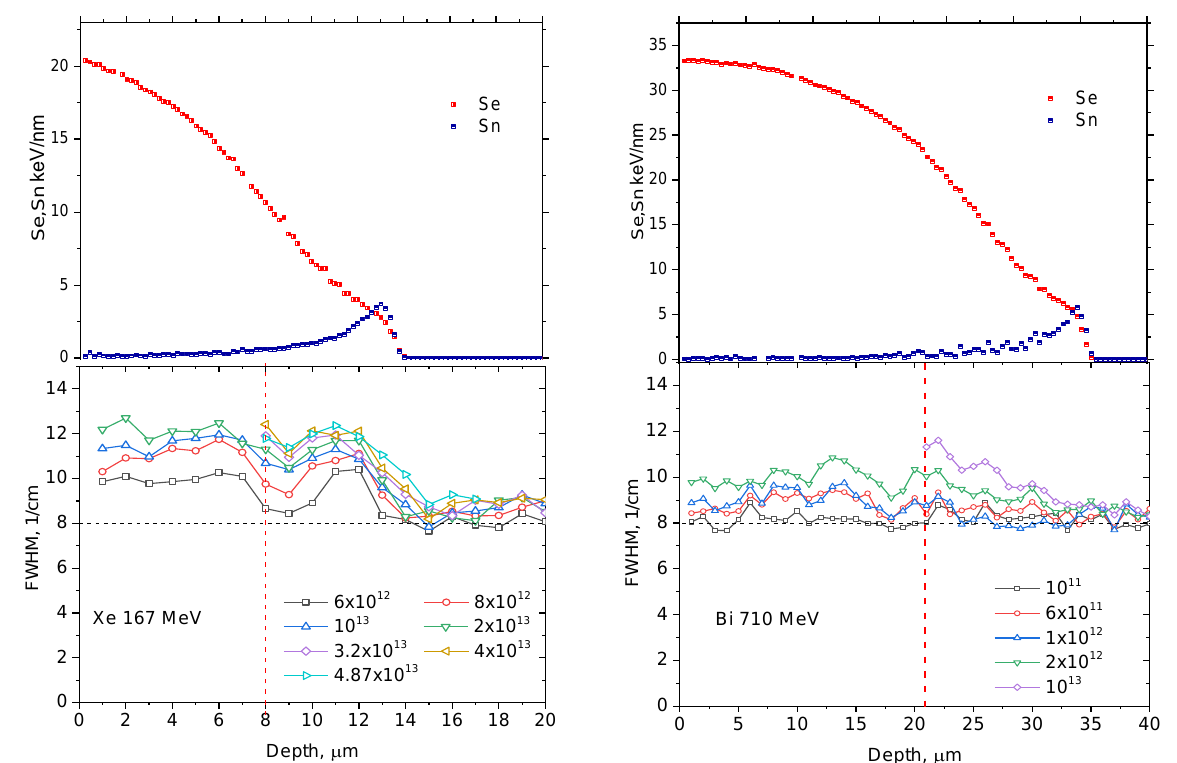
Figure 2. Nuclear (Sn) and ionization (Se) energy loss profiles and variation of the FWHM of 204 cm − 1 line depth profiles with Xe and Bi ion fluence.